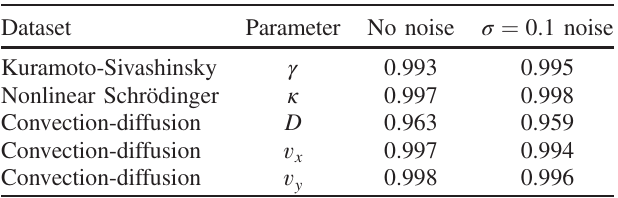
TABLE I. R 2 correlation coefficients from linear fits of the relevant latent parameters (Fig. 2) with the ground truth physical parameters for each dataset — both with and without added noise. For the three-parameter convection-diffusion dataset, the diffu- sion constant D is fit with a corresponding extracted latent parameter, while the drift velocity components v a corresponding two-dimensional subspace of the latent param- eters due to the inherent rotational symmetry.